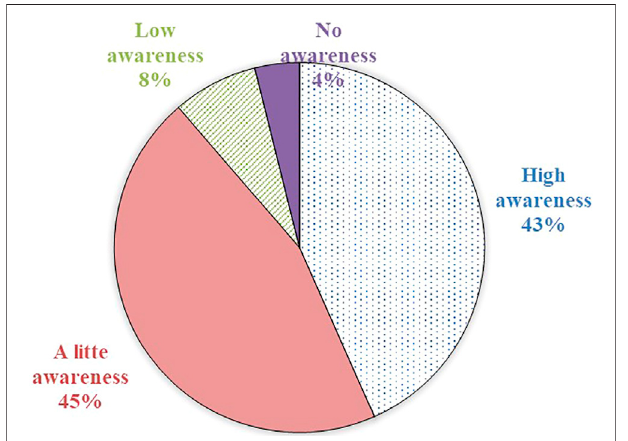
FIGURE 9 | Survey result of consumers ’ HEMS browsing